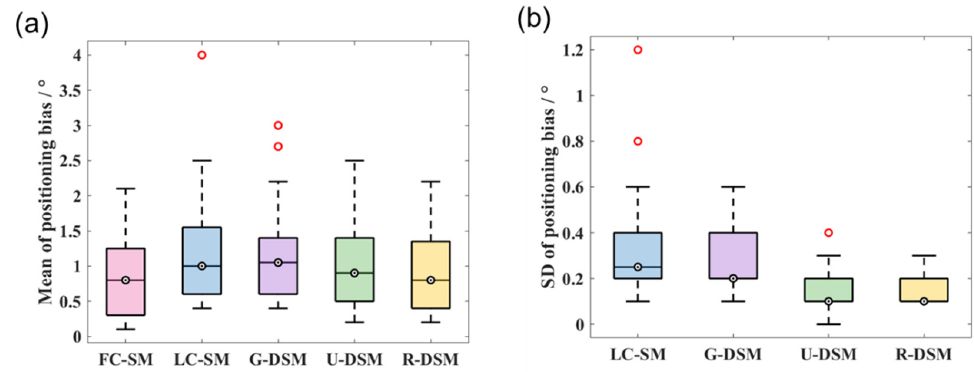
Figure 14. Box plots of ( a ) mean values and ( b ) SD values of positioning bias at 36 different source positions for 99m Tc source in intra-device evaluation.